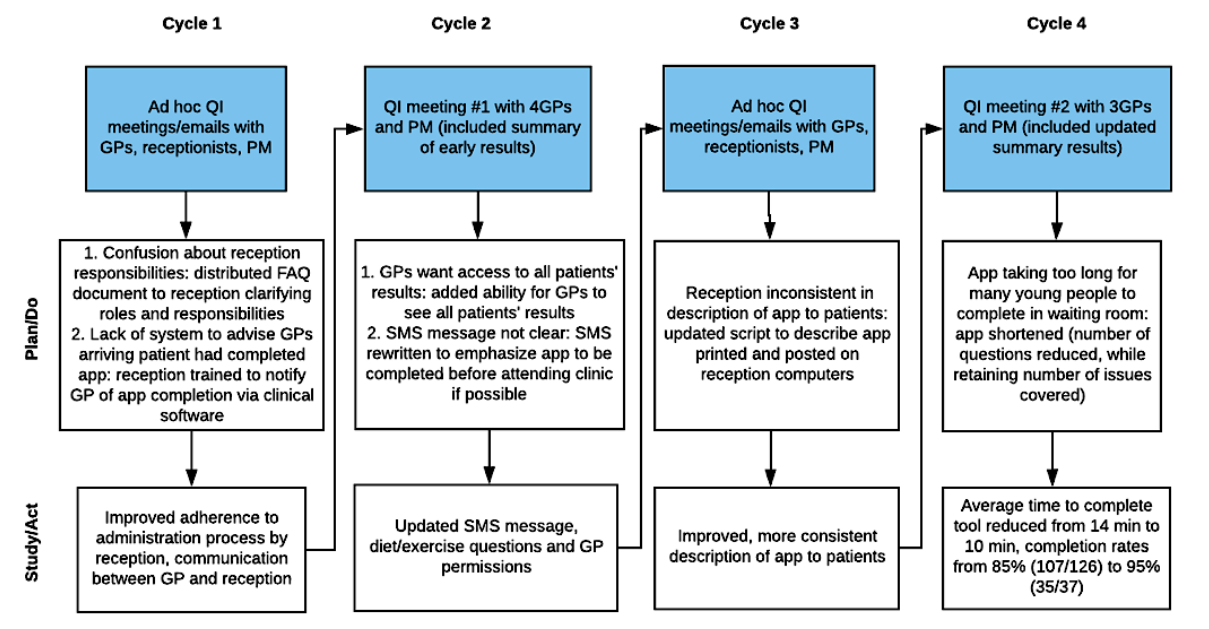
Figure 1. Iterative cycles of quality improvement (QI) activities and results using the Plan-Do-Study-Act framework by general practitioners (GPs),